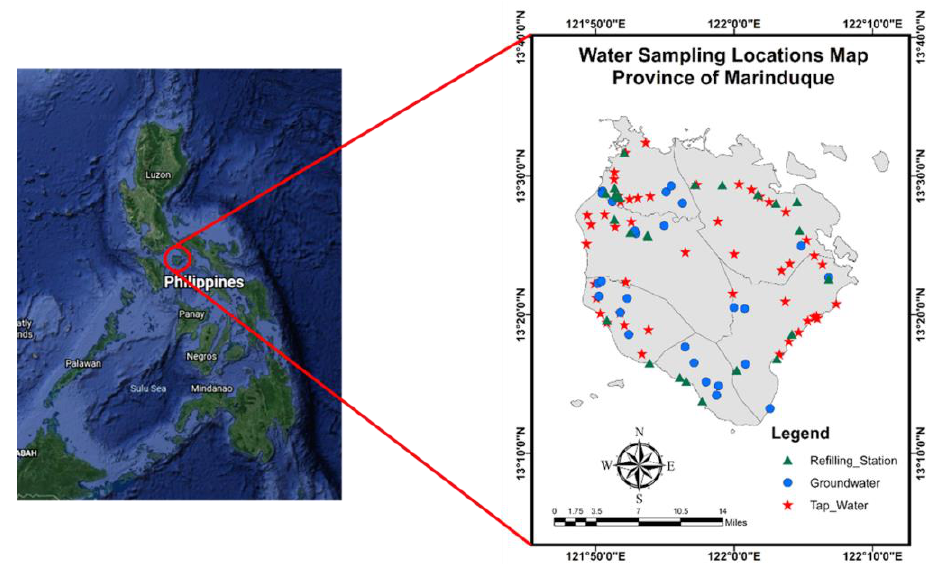
Figure 1. A map of the Philippines showing Marinduque Island as a zoomed-in inset, including domestic water sampling locations for this study.